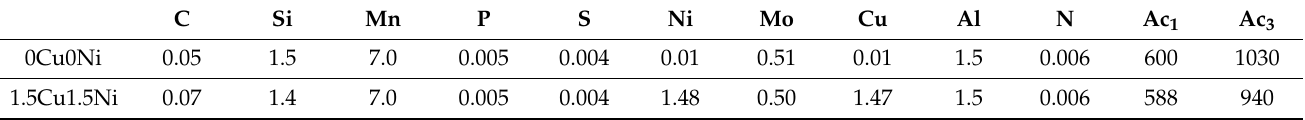
Table 1. Chemical composition of the investigated alloys (chemical compositions in wt. %, transformation temperatures in ◦ C).